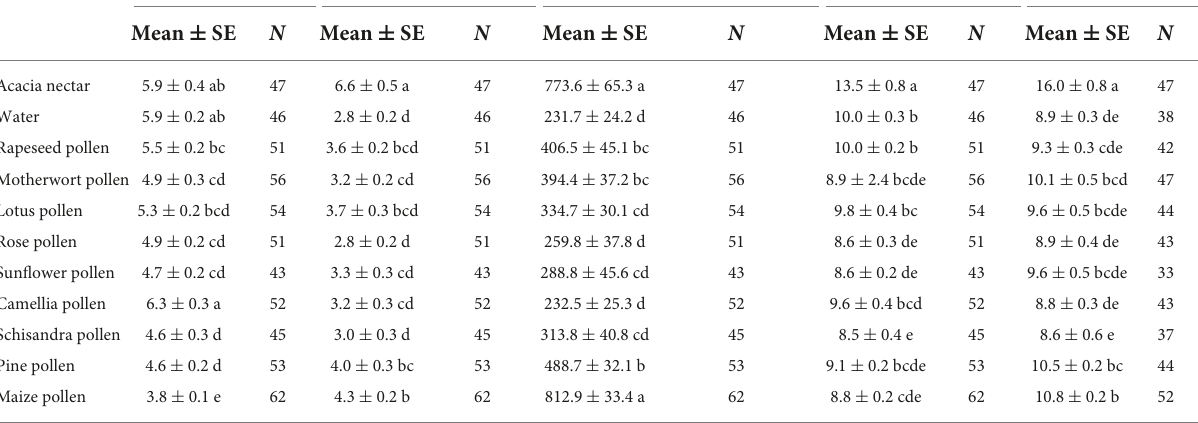
TABLE 3 Means ( ± SE) for longevity and fecundity variables for adults of Mythimna loreyi on different diets.